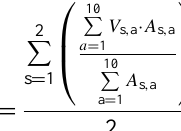
Fig. 3. Annual NPP of forest areas in Germany for 2000 and 2001. High NPP is shown in green, moderate NPP in yellow, and low NPP in red. Grey pixels represent areas which do not belong to the GLC2000 classes glc-2, glc-3, glc-4 or glc-6 (see also Table 1). Blue pixels represent pixels designated as forest in GLC2000, but that have less than 10% forest cover according to VCF; their mod- elled NPP is therefore close to zero despite being considered forest.